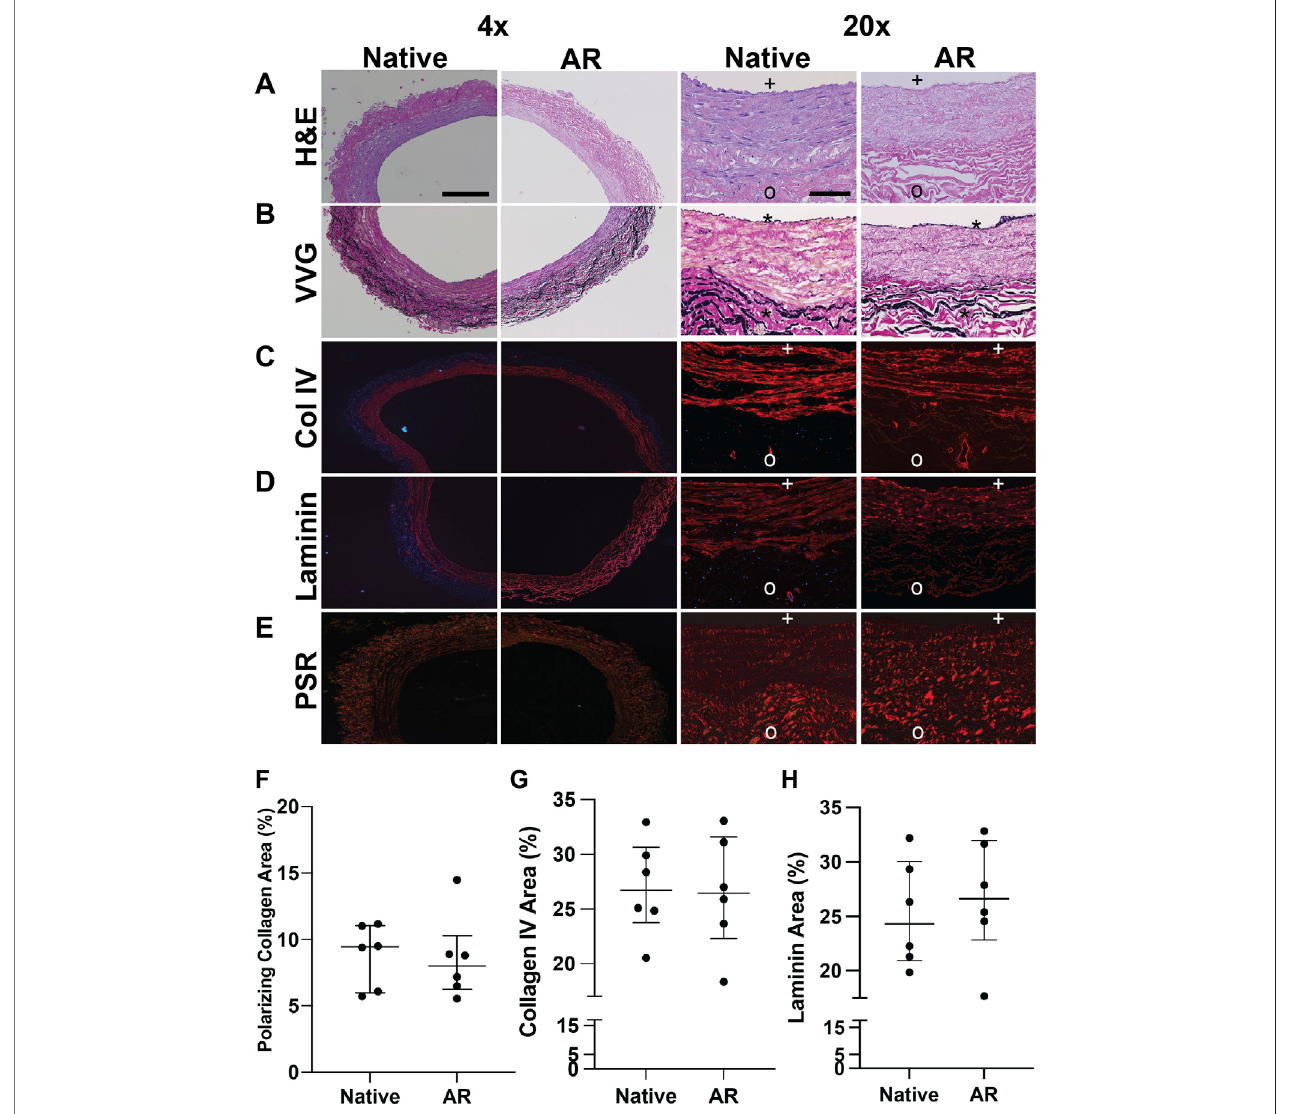
FIGURE1| Macromolecular structure and contentretentioninAR – SVECMscaffolds. Basementmembraneproteins are present inthebasement membraneside (BM) of the vessel (marked with + ), and are completely absent in the non-basement membrane (NBM) side (marked with o). H&E images of SV segments demonstrate complete acellularity of AR-scaffolds, while preserving the native collagen content and organization (A) . Elastin content and organization assessed via Verhoeff van Geison staining (VVG) demonstrate the retention of native SV internal (*) and external elastic laminae in AR-scaffolds (B) . Content and organization of basement membrane proteins (Col IV (C) and laminin (D) ) in the basement membrane side of AR-SV ECM scaffolds were unchanged when compared to native tissue. Collagen alignment (PSR and polarized light) and immuno fl uorescence staining demonstrates the capability of AR tissue processing method of retaining the native SV collagen macromolecular structure and organization (E) as assessed by percent birefringence using PSR polarized light (F) , percent collagen IV (G) , and laminin (H) . 4 x images scale bar 200 µm. 20 x images scale bar 50 µm.